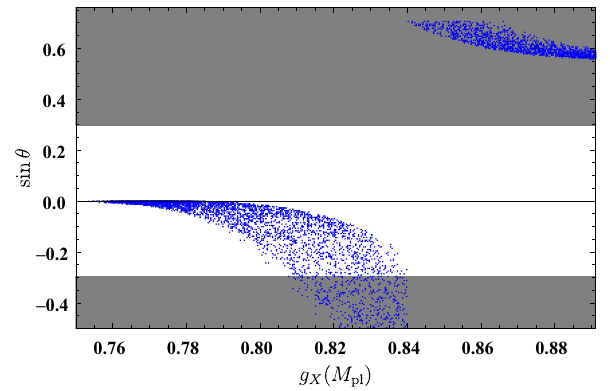
Fig. 2 Region plot for the mixing angle, sin θ , as a function of (cid:4) (cid:5) M pl g X . The grey shadow region ( | sin θ | > 0 . 3) is excluded by the collider experiments